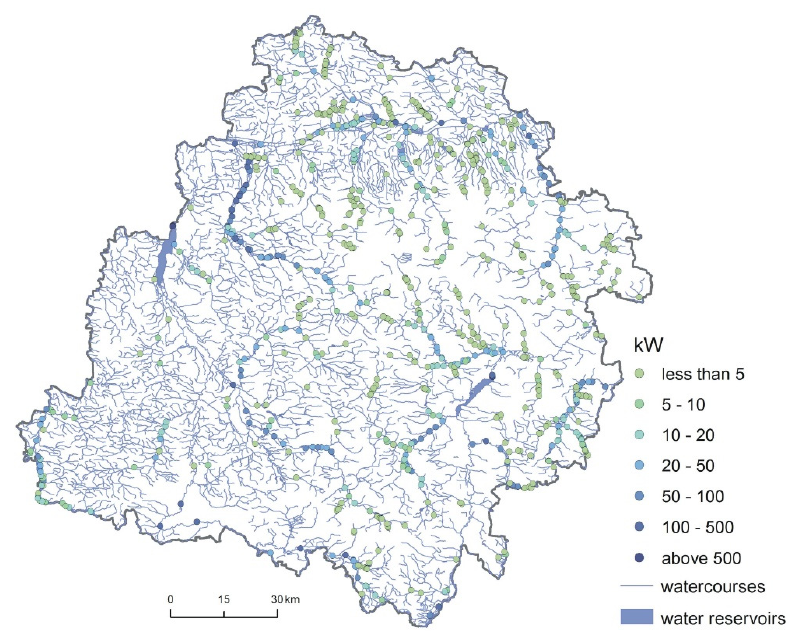
Figure 10. Localization of water dams and power of the potential hydropower plants in the Ł ódzkie voivodeship (own elaboration). The power of all the potential hydropower plants in the Małopolskie voivodeship on dams is 101.0 MW (Figure 11).